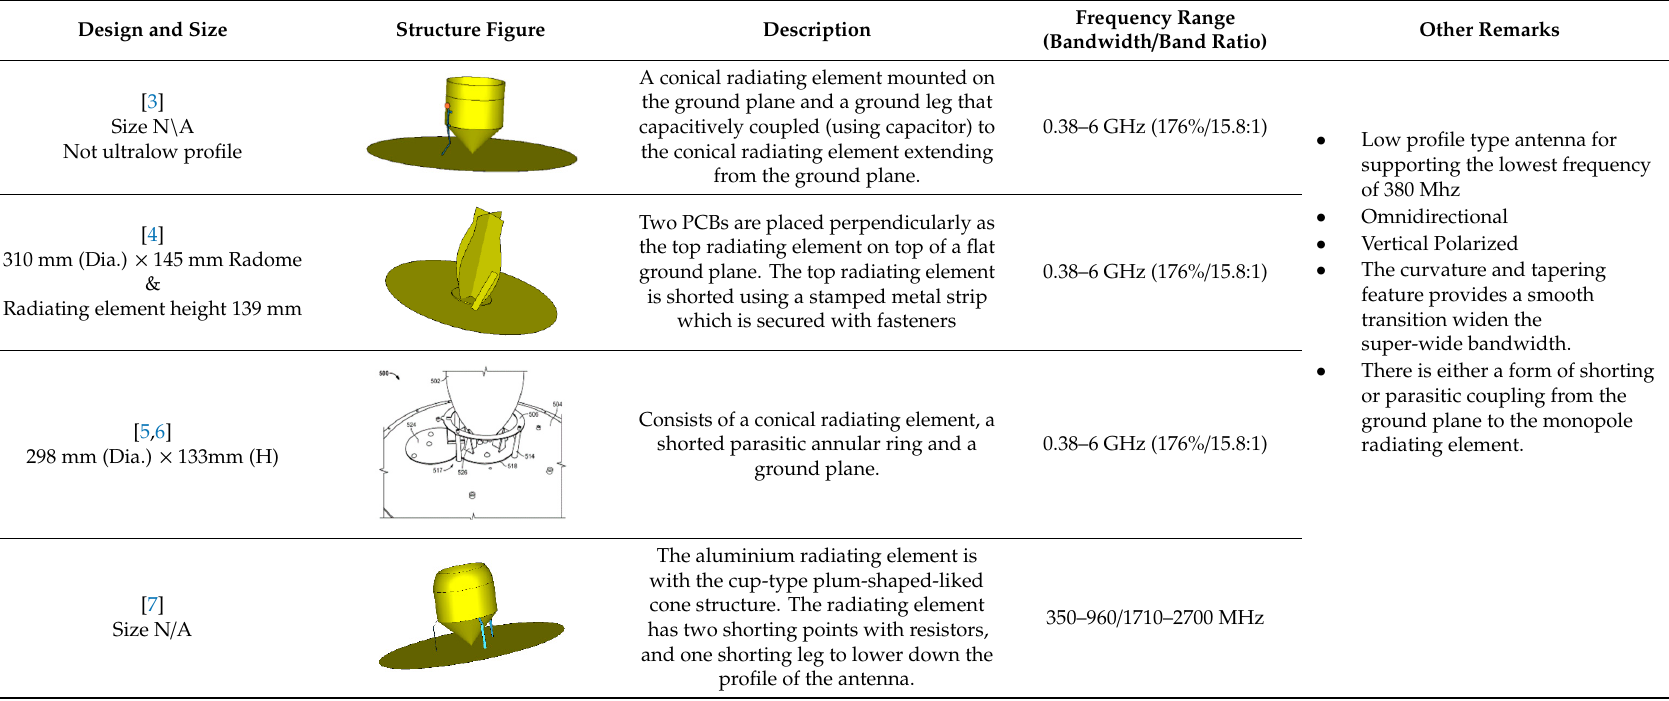
Table 6. Comparison summary of other works and the proposed design.